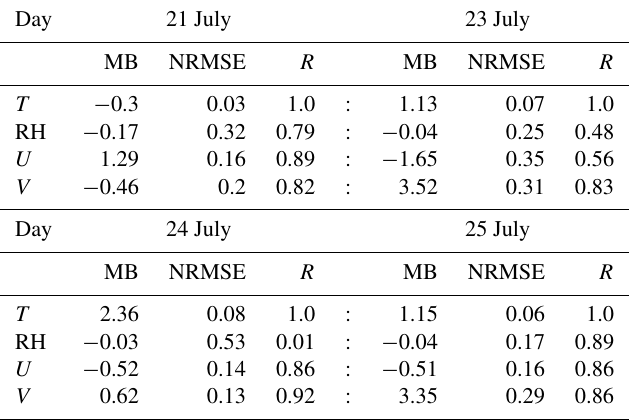
Table A3. Simulation scores for meteorological vertical profiles for 4d in July 2015 at 12:00LT at Quinta Normal station in Santiago. T is the air temperature, RH is the relative humidity, U is the zonal wind speed, and V is the meridional wind speed along the vertical